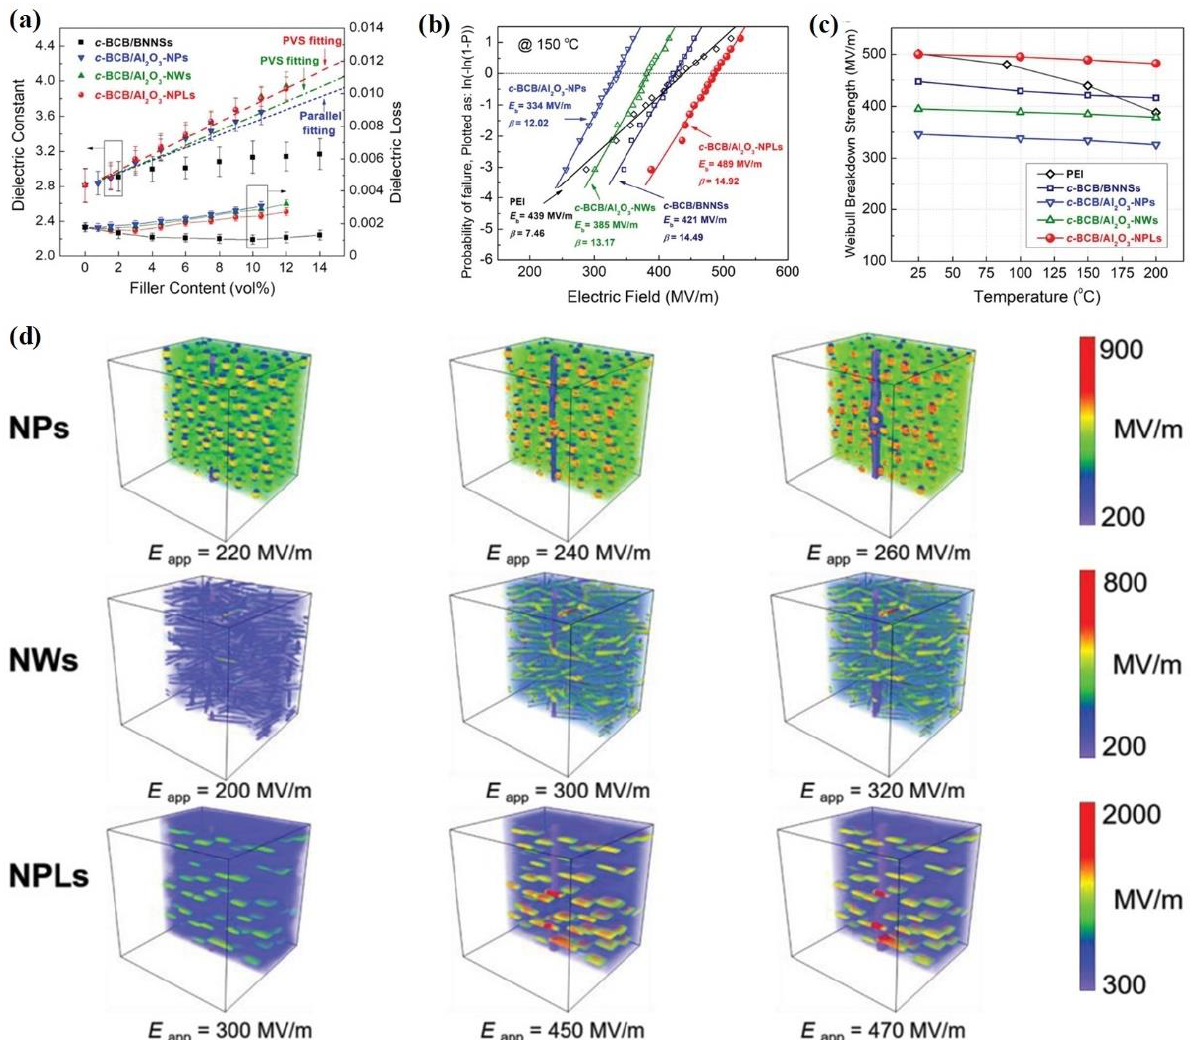
Figure 12. ( a ) Dielectric constant and loss of the composites as a function of filler content measured at room temperature and 1 kHz. ( b ) Weibull statistic of dielectric breakdown strength of PEI and the nanocomposites at 150 °C. ( c ) Temperature- dependent Weibull breakdown strength of PEI and the nanocomposites at 150 °C. ( d ) The corresponding electric field distribution was computed by phase-field simulations of the c -BCB nanocomposites with 7.5 vol % Al 2 O 3 NPs, NWs, and NPLs at 150 °C and varied applied electric fields. Reproduced with permission from Ref. [84]. Copyright 2019, Wiley – VCH.